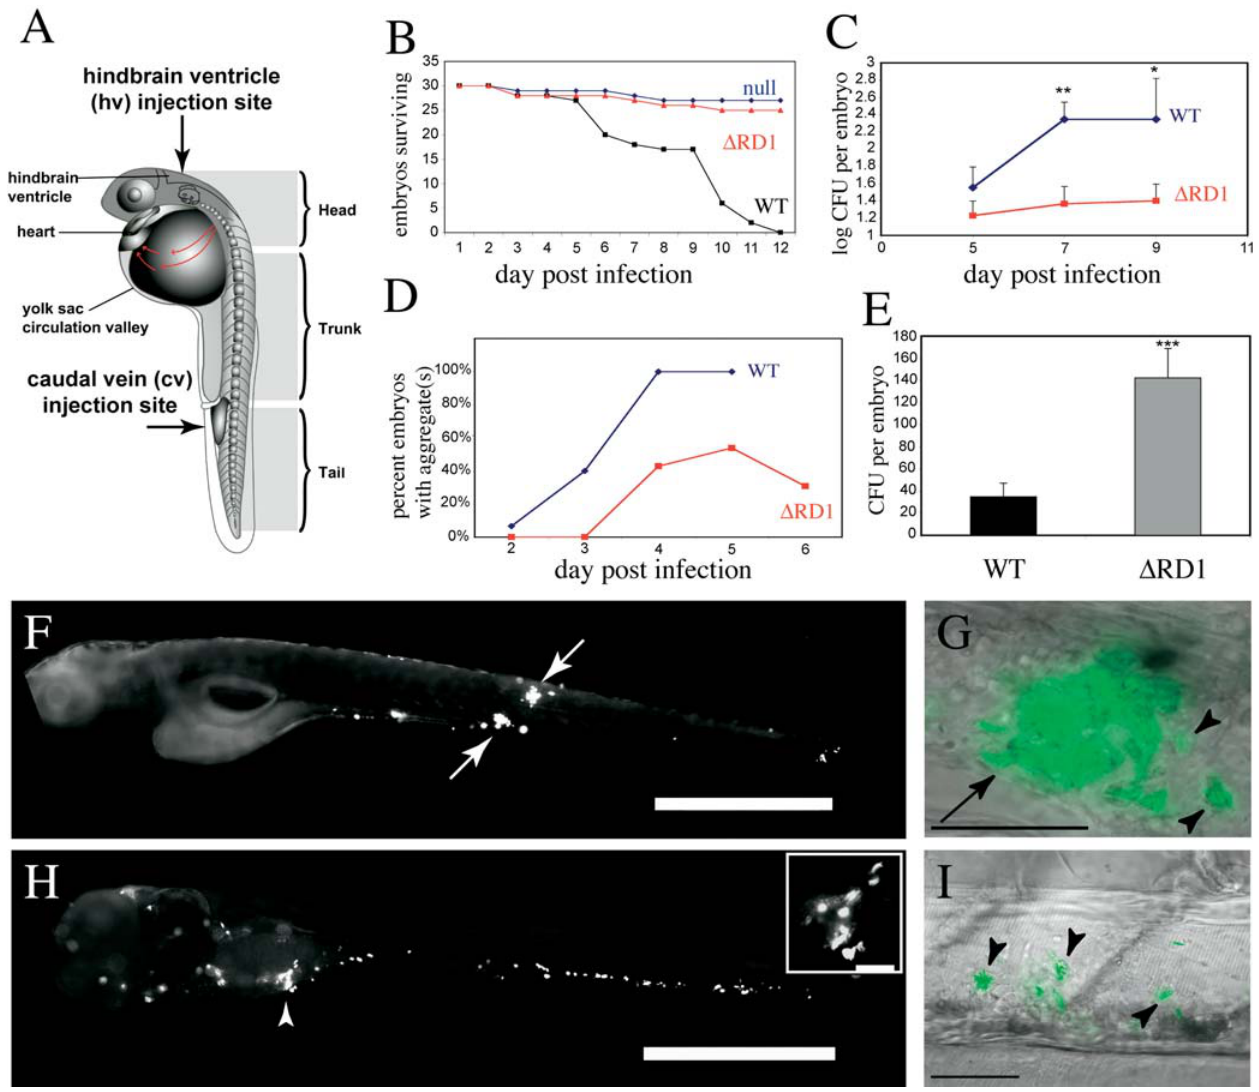
Figure 3. D RD1 Is Attenuated in Zebrafish Larvae (A) Diagram of the zebrafish embryo/larva. Arrows indicate the two injection sites used in this study. (B) Survival of embryos infected with D RD1 (410 CFU) or WT bacteria (250 CFU) and null-injected embryos. (C) Whole embryo bacterial counts of WT- and D RD1-infected embryos. Infecting doses: 32 CFU for WT, 36 CFU for D RD1. Error bars are 6 SEM (** p = 0.0075 comparing 7-d postinfection WT to 7-d postinfection D RD1; * p = 0.05 comparing 9-d postinfection WT to 9-d postinfection D RD1, unpaired Student’s t -test). (D) Time of aggregate formation, showing delayed aggregation in the D RD1-infected embryos ( n = 13) as compared to WT-infected embryos ( n = 15). Infecting doses: 131 CFU for WT, 301 CFU for D RD1. (E) Whole embryo bacterial counts of WT- and D RD1-infected embryos on day of aggregate formation. Infecting doses: 36 CFU for WT, 78 CFU for D RD1. Error bars are 6 SEM (*** p = 0.0008, unpaired Student’s t -test; D RD1 n = 28, WT n = 29). (F) Fluorescent image of WT-infected embryo at 6 d postinfection with two aggregates (arrows). Scale bar, 200 l m. (G) WT-infected embryos with higher magnification overlay of fluorescent and DIC images showing an aggregate (arrow) with individual infected macrophages that are migrating toward aggregate (arrowheads). Scale bar, 50 l m. (H) Fluorescent image of D RD1-infected embryo at 6 d postinfection that has not formed any aggregates. Note the numerous infected macrophages throughout the head, body, and tail. Arrowhead and close-up insert (scale bar, 50 l m) show infected macrophages close to each other, but not aggregating. Scale bar, 200 l m. (I) D RD1-infected embryo under higher-magnification overlay of DIC and fluorescent images showing three individual infected macrophages (arrowheads). Scale bar, 50 l m. DOI: no aggregates) in the tissues, the embryos were superinfected with either WT or D RD1 red-fluorescent bacteria. As